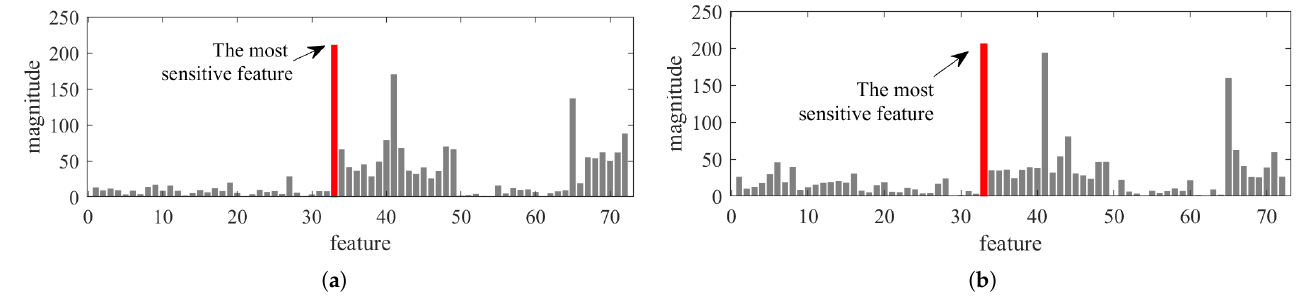
Figure 6. The feature importance distribution. ( a ) The LESO residual features. ( b ) The direct residual features. The x-axis is the feature number. For a feature with the i-th statistical parameter of the m-th WPT node, it is numbered as 72. If the nodes are sorted according to the frequency band, the order is: 7, 8, 10, 9, 13, 14, 12, 11 (nodes from the third layer after three-layer